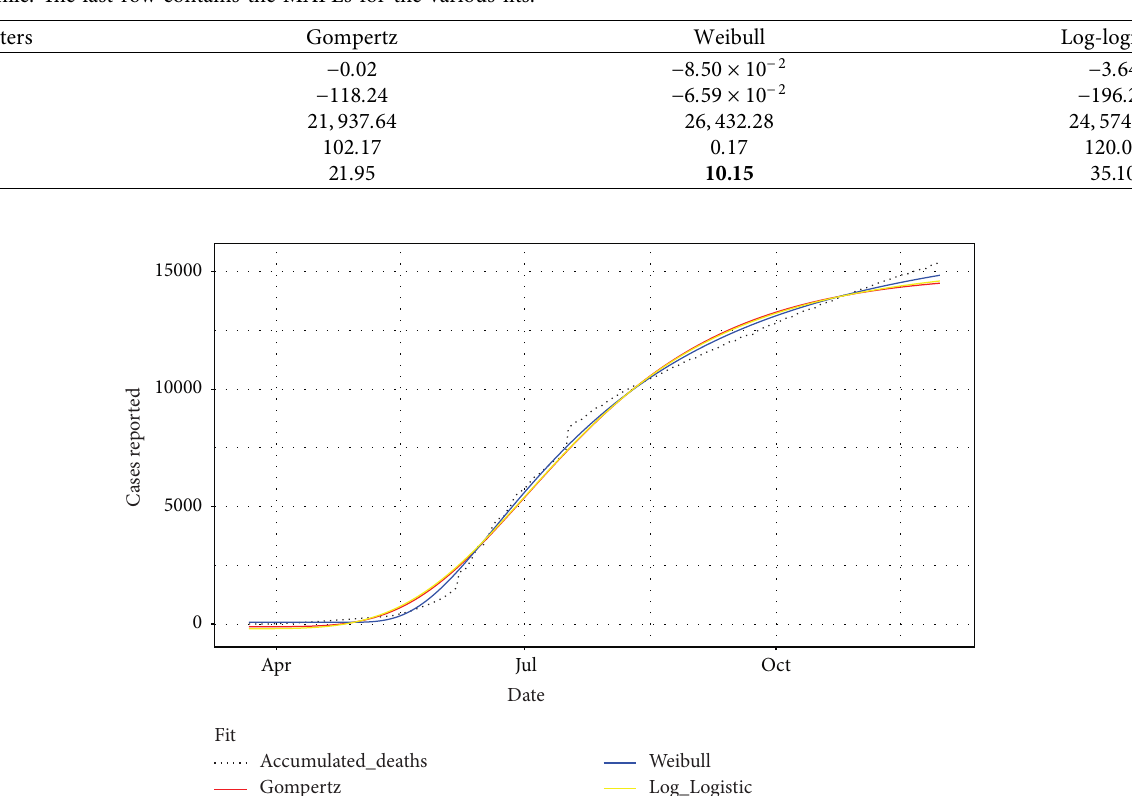
Figure 11: Fit of the growth curve models to the number of deaths accumulated by COVID-19 in Chile (using data from March 22 to November 30,